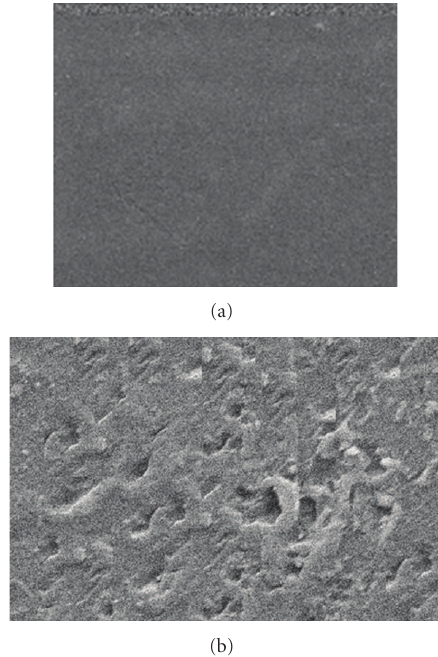
Figure 7: SEM Images of (a) Virgin PP (b) IPP-g-MMA at X